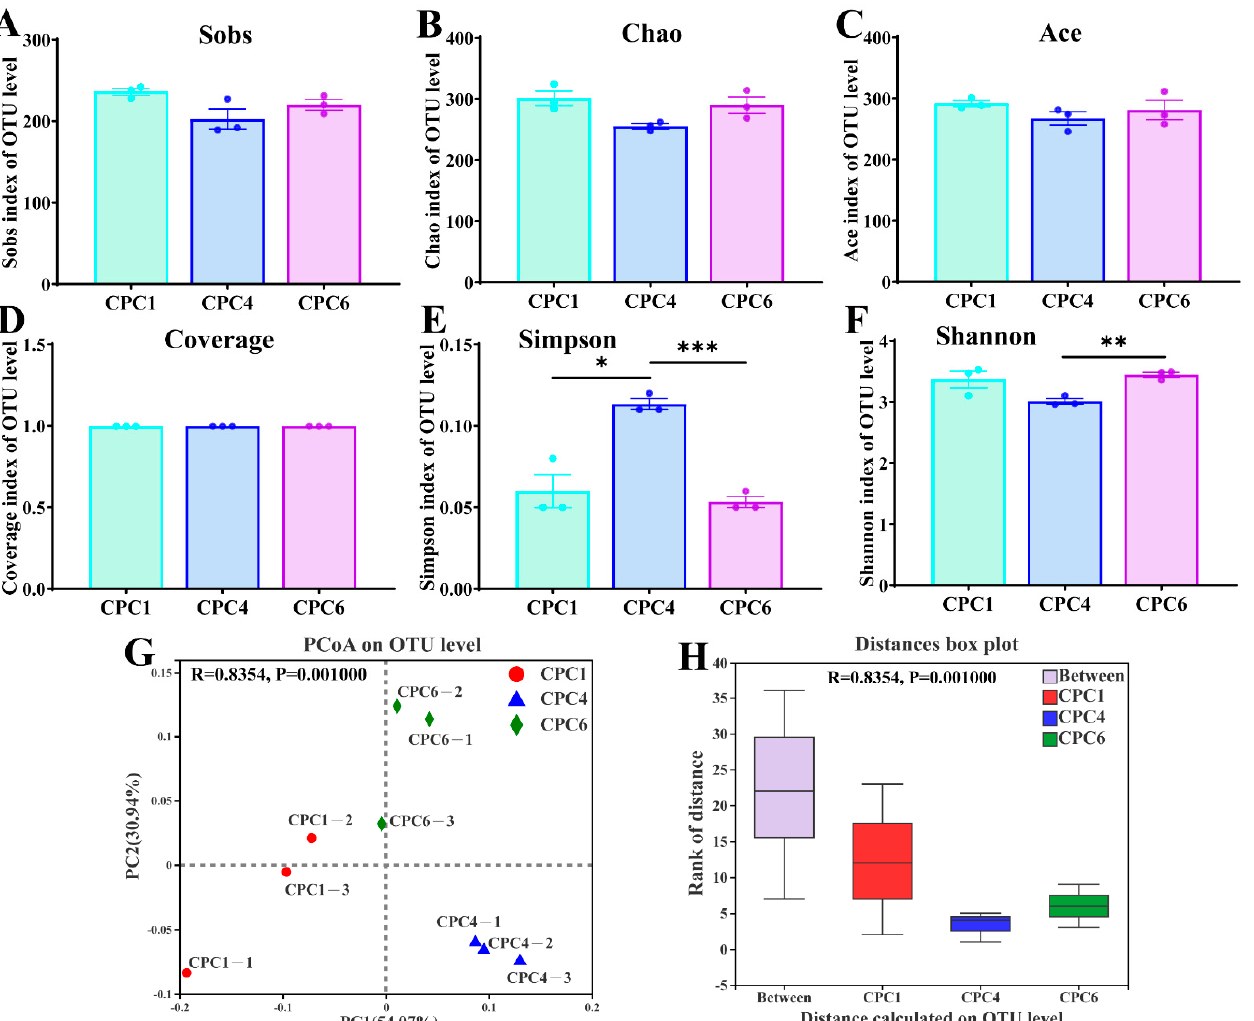
Figure 8. Alpha diversity analysis and Beta diversity analysis of grass carp intestinal microbiota from different dietary protein treatments. The Sobs index ( A ), Chao index ( B ), and Ace index ( C ) were used to reflect the microbial community richness. The coverage index ( D ) represents the community coverage. The Simpson index ( E ) and Shannon index ( F ) were used to reflect the microbial community diversity. Significance analysis was performed using Welch’s t -test, and two groups with significant differences were marked (* p ≤ 0.05, ** p ≤ 0.01, *** p ≤ 0.001). ( G ) Principal coordinates analysis of the weighted UniFrac scores of the microbial communities. ( H ) ANOSIM analysis (analysis of similarities) is a nonparametric test used to test whether the differences between groups are significantly greater than the differences within groups, where the “Between” box represents the between-group differences, and the other colored boxes represent the within-group